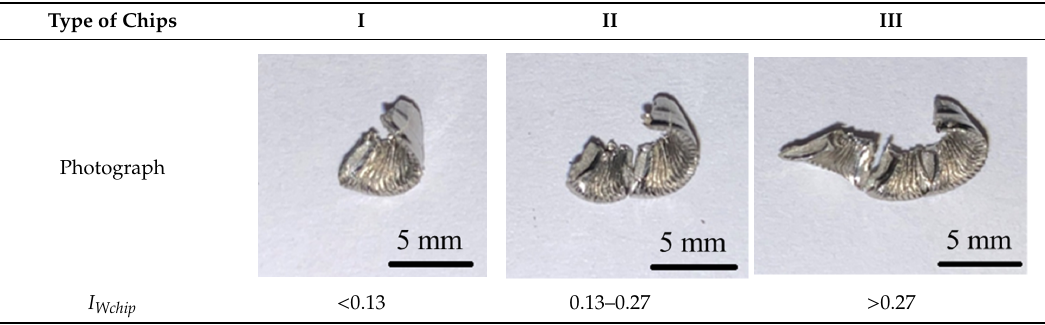
Table 3. Classification of different chips.